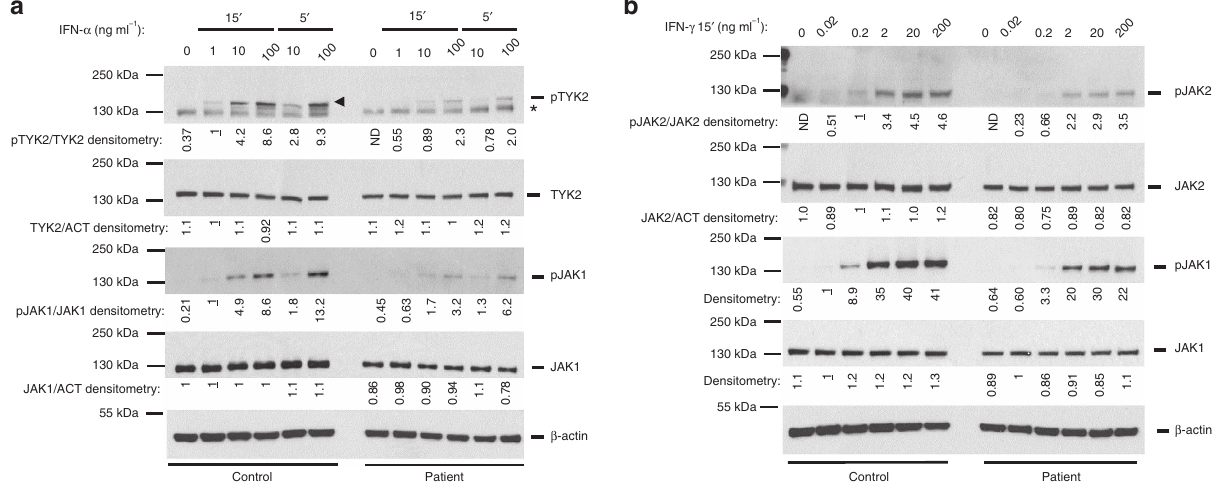
Figure 6 | Reduced amounts of phosphorylated TYK2 and JAK2 in the patient’s fibroblasts. ( a , b ) Primary fibroblasts from the patient or a healthy control were treated with the indicated concentrations of IFN- a ( a ) or IFN- g ( b ) and protein extracts were subjected to immunoblotting. *shows non- specific protein species detected by the antibody. Arrowhead shows specific bands. Representative of three independent experiments (IFN- a 15’ and IFN- g ) or one experiment (IFN- a 5’). Fold change of band densitometry is indicated (numbers below bands and bar graphs in Supplementary Fig. 8). STAT1 phosphorylation after stimulation with IFN- a and IFN- g . Forced expression of JAK1 P832S rescued STAT1 phosphorylation to a similar extent as JAK1 WT , whereas expression of the JAK1 P733L or JAK1 P733L/P832S proteins led to significantly reduced STAT1 phosphorylation. Taken together, these results indicate that the double-mutant JAK1 P733L/P832S protein is functionally deficient and that its defect is mostly caused by the P733L mutation, whereas the contribution of P832S is less pronounced.